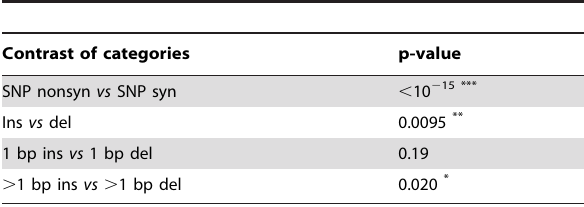
Table 3. Tests contrasting the distribution of sample